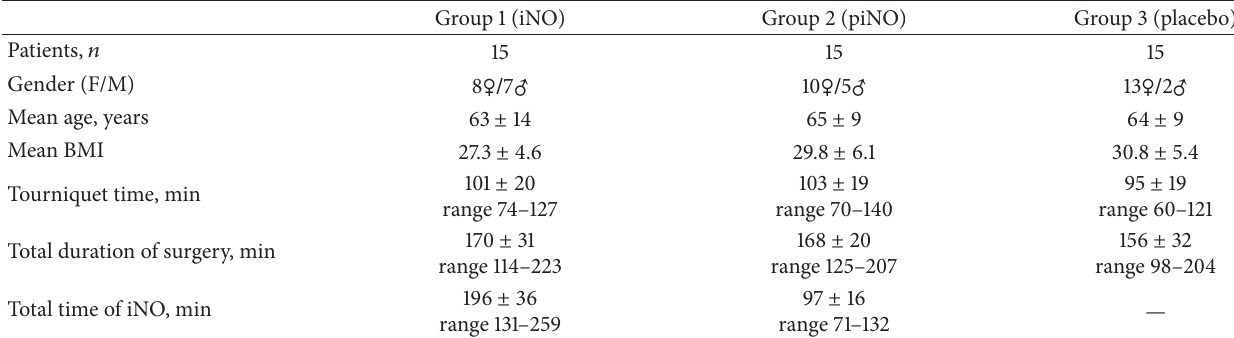
Table 1: Patient